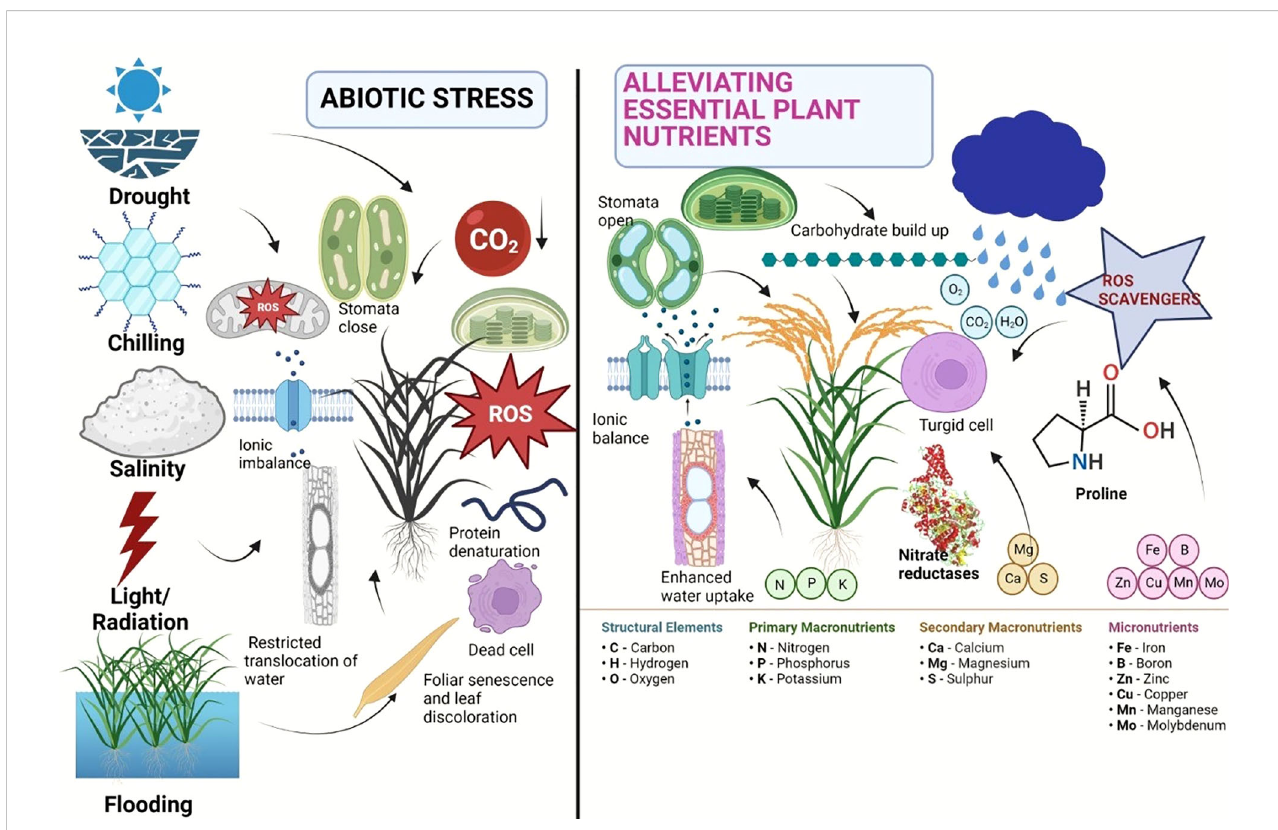
FIGURE 1 Negative impacts of abiotic stress and their alleviation using plant nutrients in